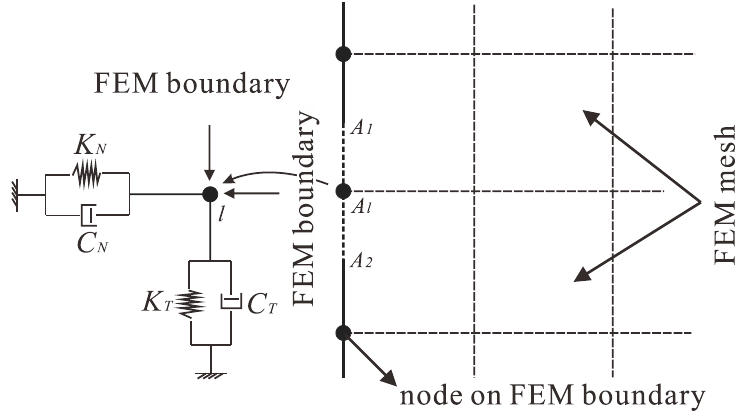
Figure 2. Layout of viscous-spring artificial boundary on FEM model.